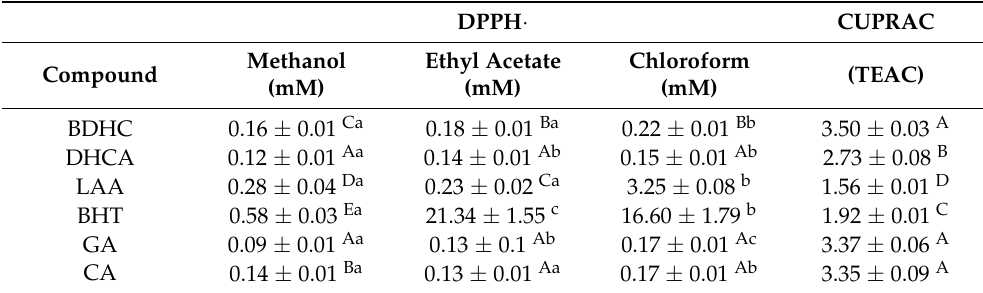
Table 1. Comparison of the antioxidant activity of dihydrocaffeic acid, its butyl ester, and commonly known antioxidants by DPPH · and CUPRAC methods. DPPH · CUPRAC Methanol Compound